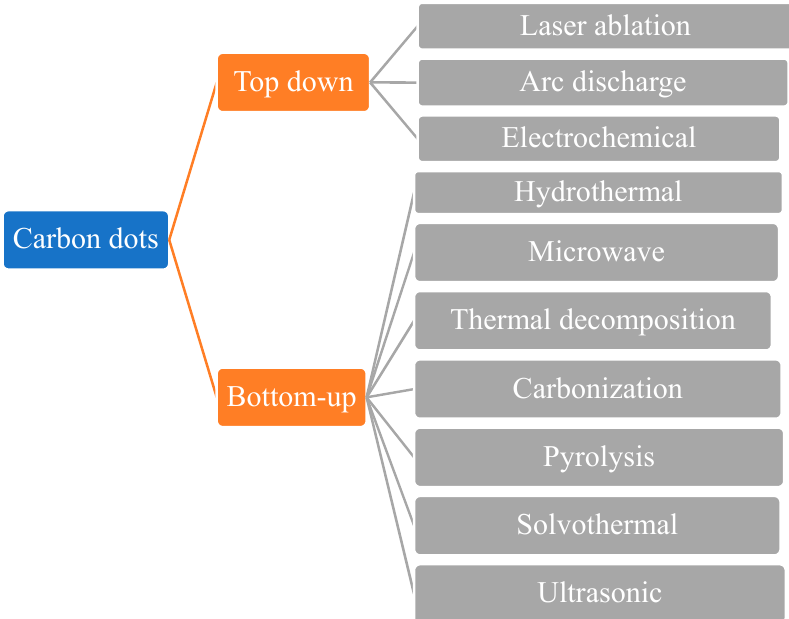
Figure 1. Different methods for the synthesis of carbon dots.